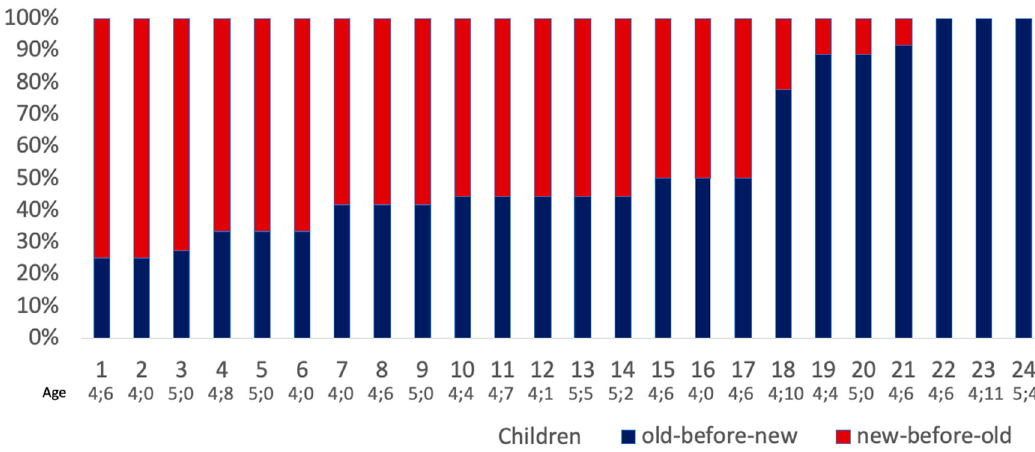
Figure 3. Mean proportions of “old-before-new” and “new-before-old” responses by child.